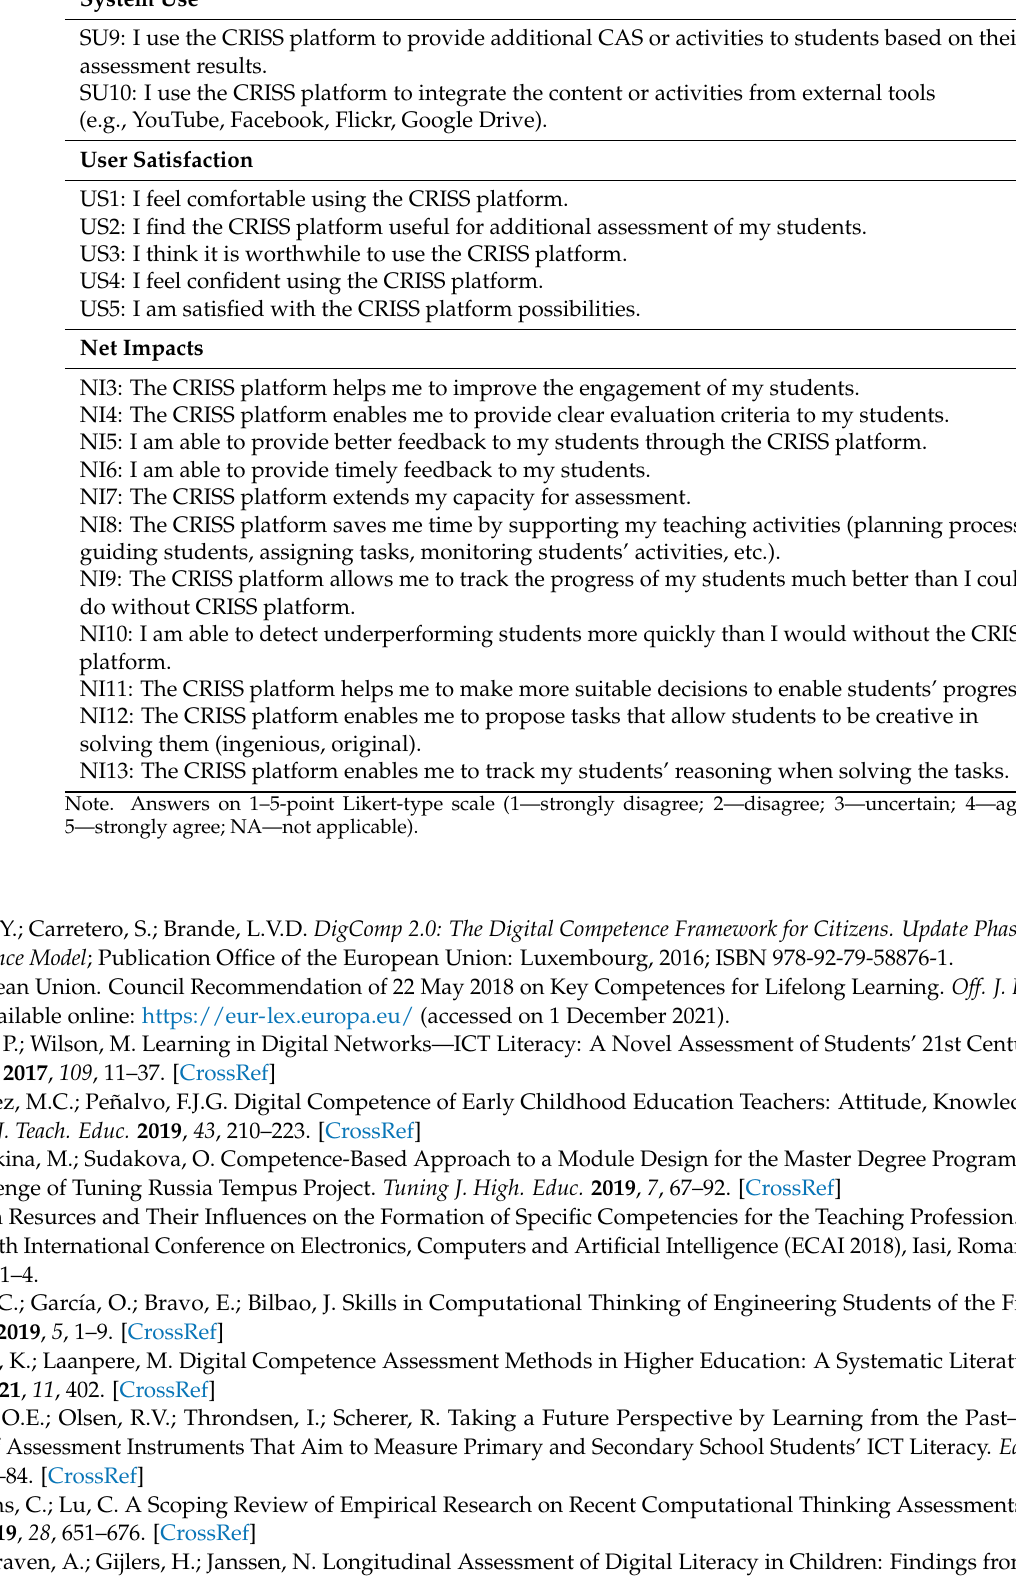
Table A1. Cont . System